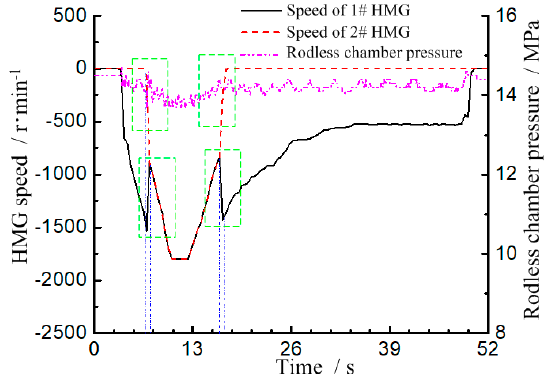
Appl. Sci. 2020 , 10 , x FOR PEER REVIEW Figure 13. Curves of the rodless pressure and speed. Figure 13. Curves of the rodless pressure and speed.